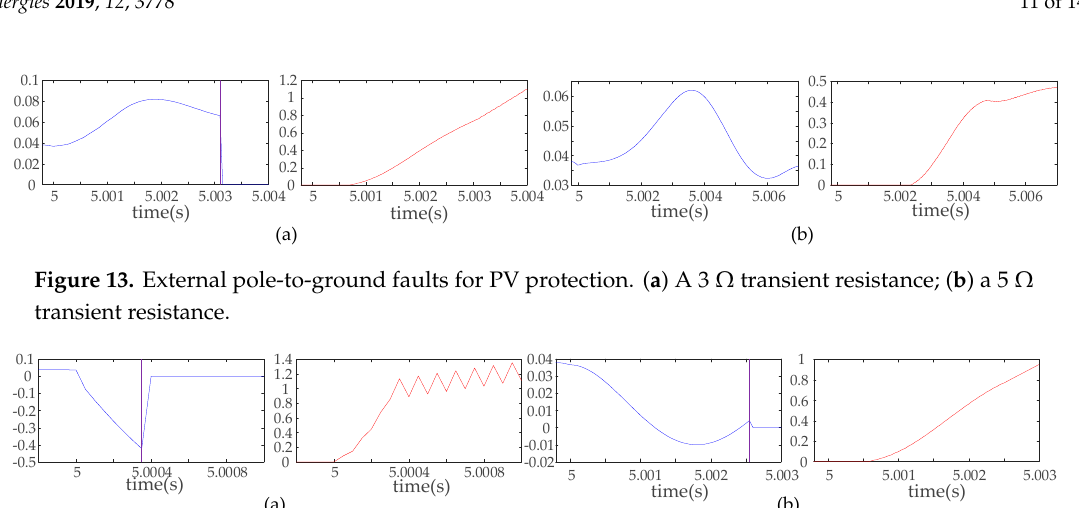
Figure 14. Internal faults for PV protection. ( a ) Pole-to-pole fault; ( b ) pole-to-ground fault with 5 Ω transient resistance.